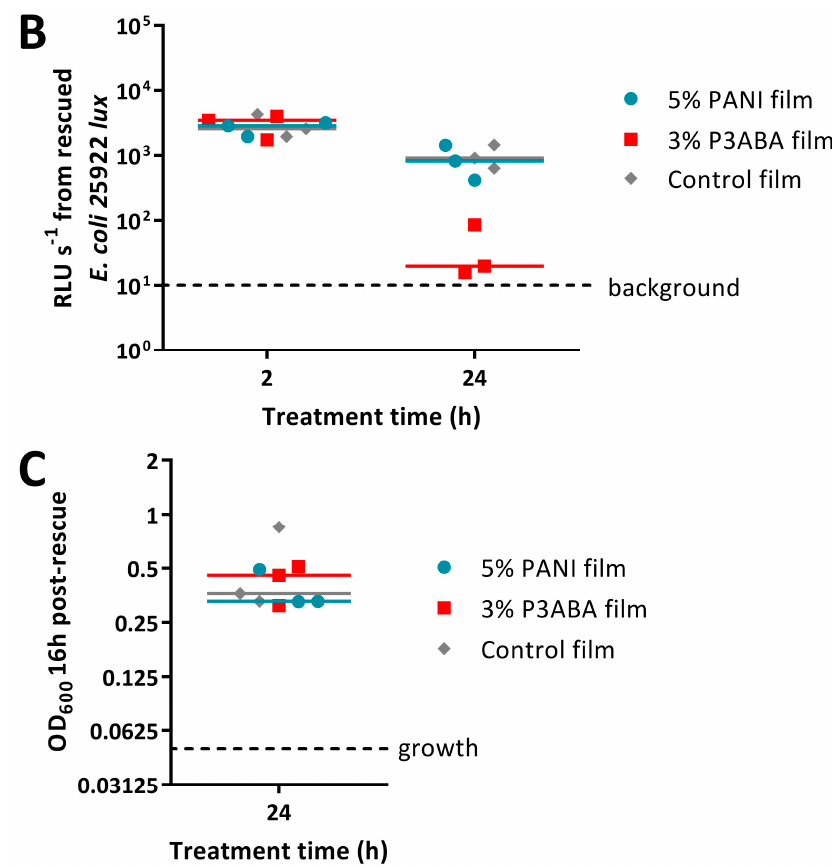
Figure 6. Sensitivity of E. coli 25922 lux and S. aureus 6538 to PANI and P3ABA films. ~10 4 CFU of E. coli ( A , B ) or S. aureus ( C ) in 10 µL LB broth was sandwiched between two pieces of PANI film, P3ABA film, or control film for 2 h ( A , B ) and 24 h ( A – C ). The cells were rescued by washing the film samples with LB broth and transferred to a 96 well plate ( B , C ). Each point represents the median of three technical replicates and each bar represents the median of each biological replicate. The rescued E. coli cells were also enumerated with plate counts ( A ). The cells in the 96 well plate were incubated at 37 °C for 16 h and light release ( B ) or OD 600 ( C ) was measured. The vertical axes show the viable cell counts ( A ) and bioluminescence measurements ( B ) from the recovered E. coli cells, and OD 600 measurements ( C ) from the recovered S. aureus cells, with each data point representing an independent experiment and the line representing the median. The limit of detection for the plate counts is 50 CFU/mL. Background luminescence readings are 10 RLU s − 1 . OD 600 readings above 0.05 are considered as growth.